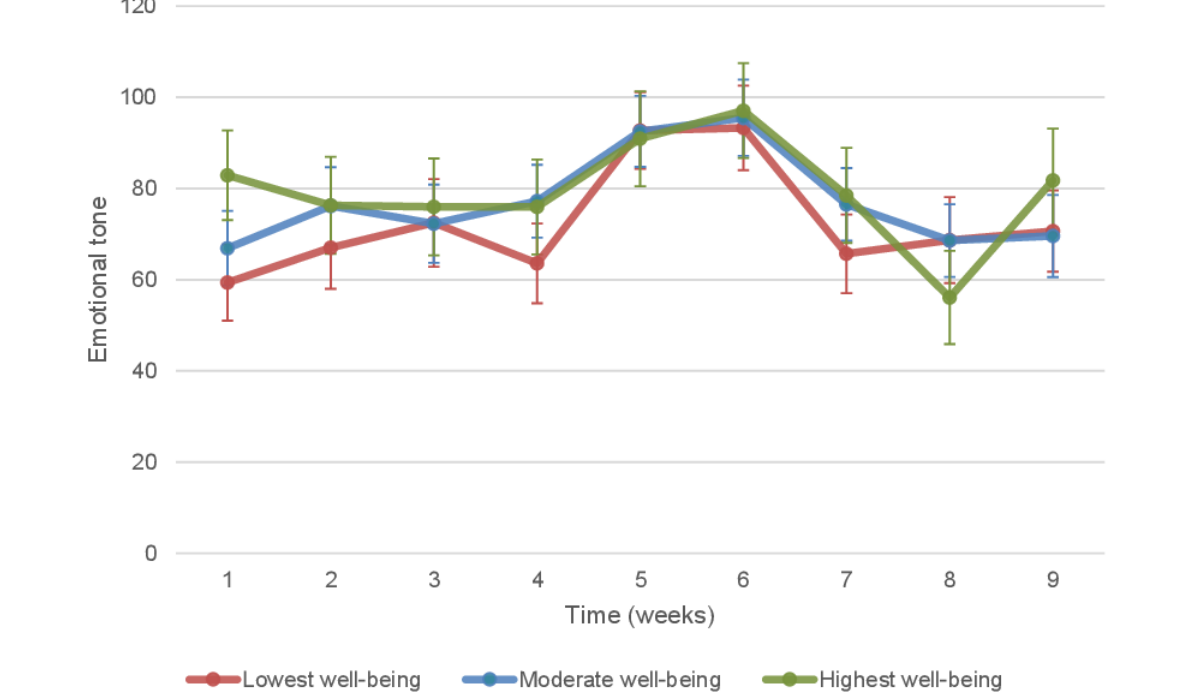
Figure 3. Trajectory of emotional tone for students with low, moderate, and high baseline well-being, adjusted for age, gender, word count, and total diary entries.